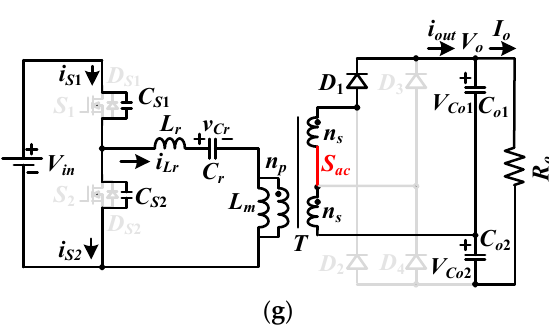
Figure 3. LLC circuits operated at low-input voltage ranges: ( a ) pulse width modulation PWM waveforms; ( b ) mode 1; ( c ) mode 2; ( d ) mode 3; ( e ) mode 4; ( f ) mode 5; ( g ) mode 6.